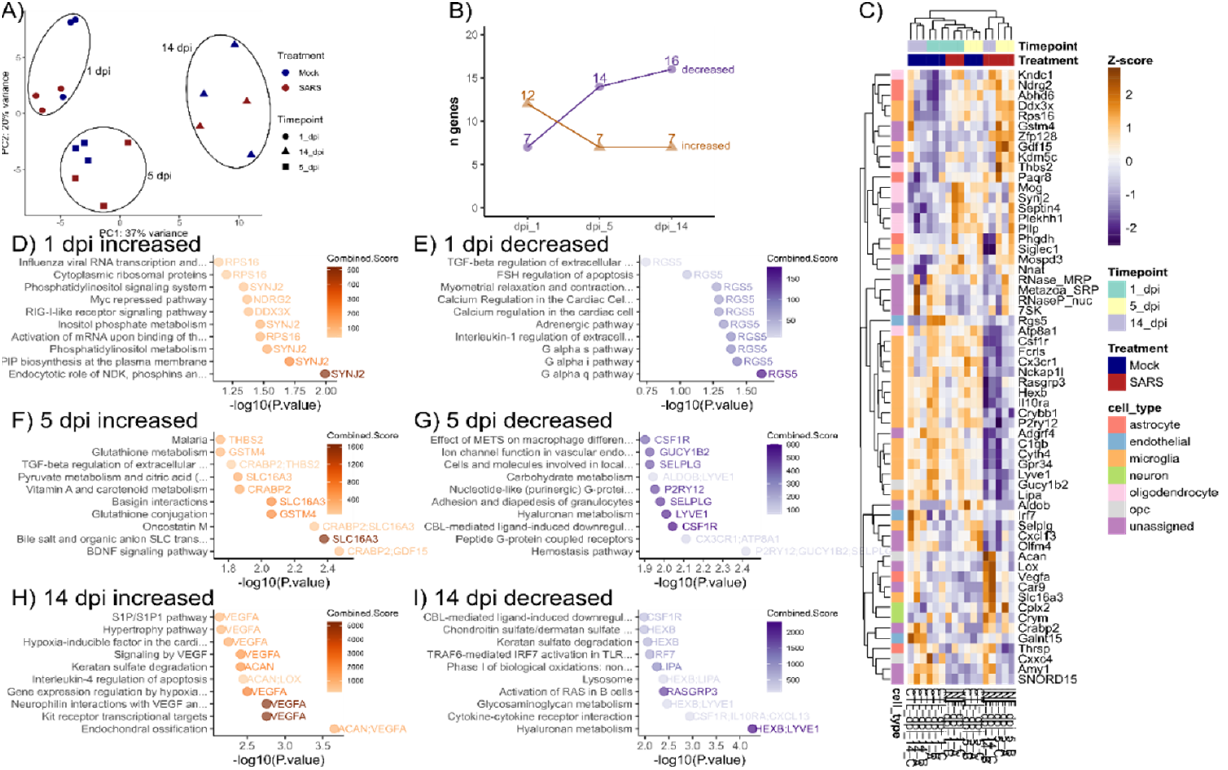
Figure 5. A limited transcriptional response is observed in hamster brain cerebellar slices infected with SARS-CoV-2. ( A ) PCA plot of all samples used for gene expression analysis at DPI 1, 5 and 14. ( B ) Number of differentially expressed genes in cerebellar sections at 1, 5 and 14 DPI. Differentially expressed genes were defined as mean read count >25, absolute value log2 (fold change) > 0.5